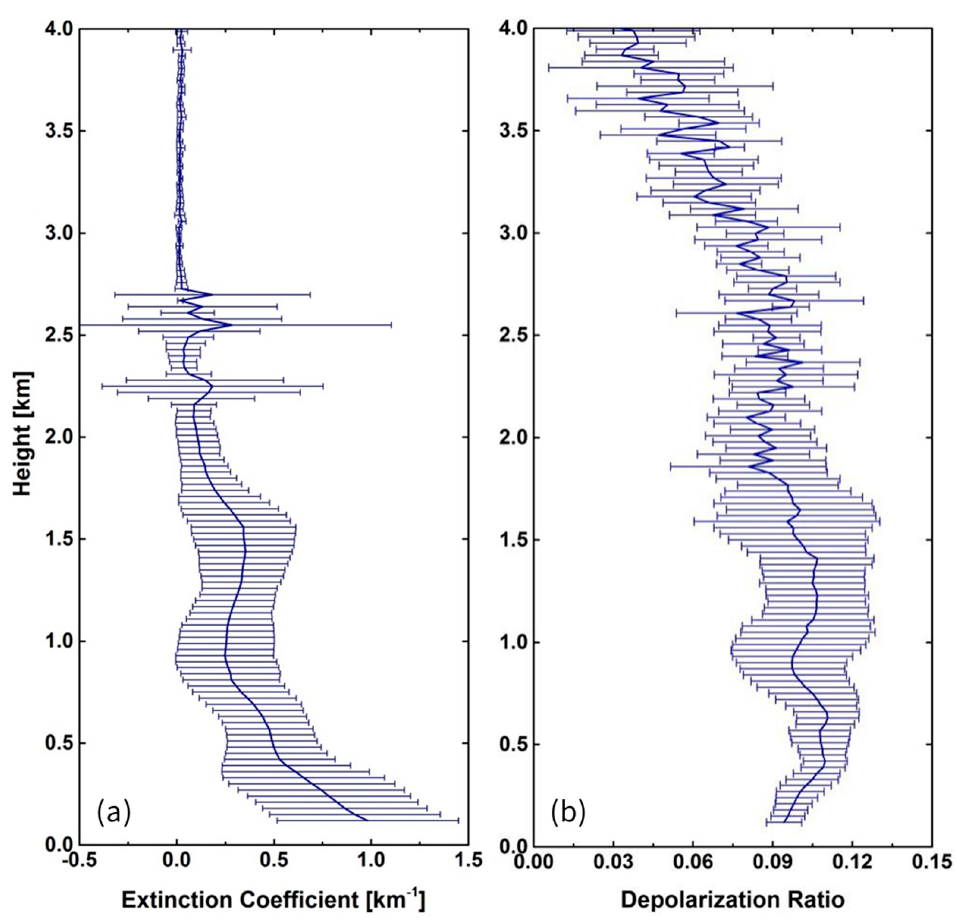
Figure 3. The mean vertical profiles of AOD-constrained extinction coefficient ( a ) and depolarization ratio ( b ) during the daytime on 2, 4, 7, and 8 December 2014 and 3, 4, 7, and 8 January 2015.